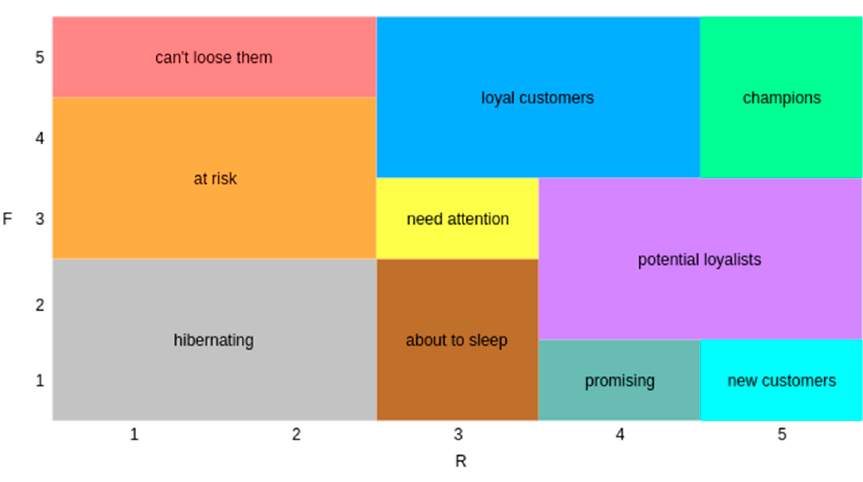
Figure 5. Segmentation map of customer clustering.